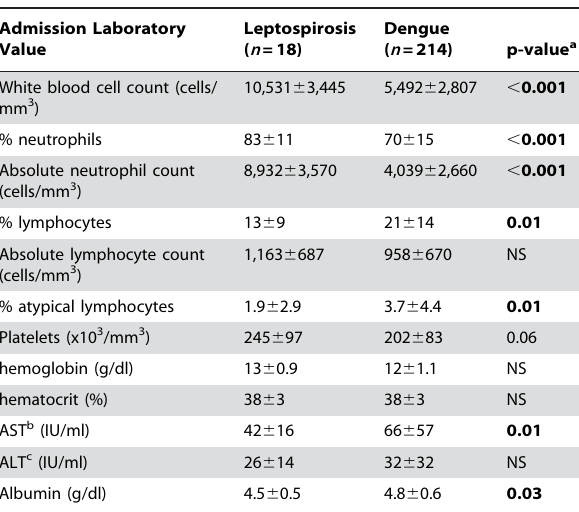
Table 3. Case-control comparison of initial laboratory values between children with leptospirosis and dengue. Values are mean 6 S.D.